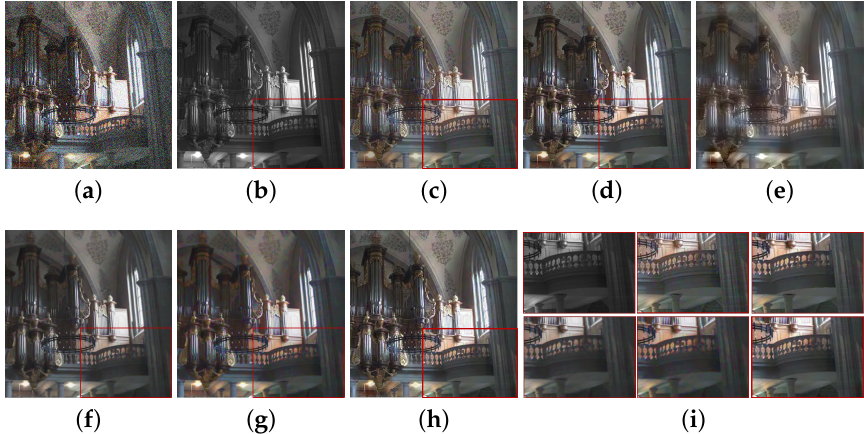
Figure 10. Experimental results for a test image. ( a ) Noisy RGB image. ( b ) NIR image. ( c ) DWLS [11]. ( d ) SM [8]. ( e ) GWS [1]. ( f ) DenseFuse [17]. ( g ) UDIF [20]. ( h ) Proposed method. ( i ) Zoomed regions of red blocks (From top left to bottom right: ( b – d , f – h